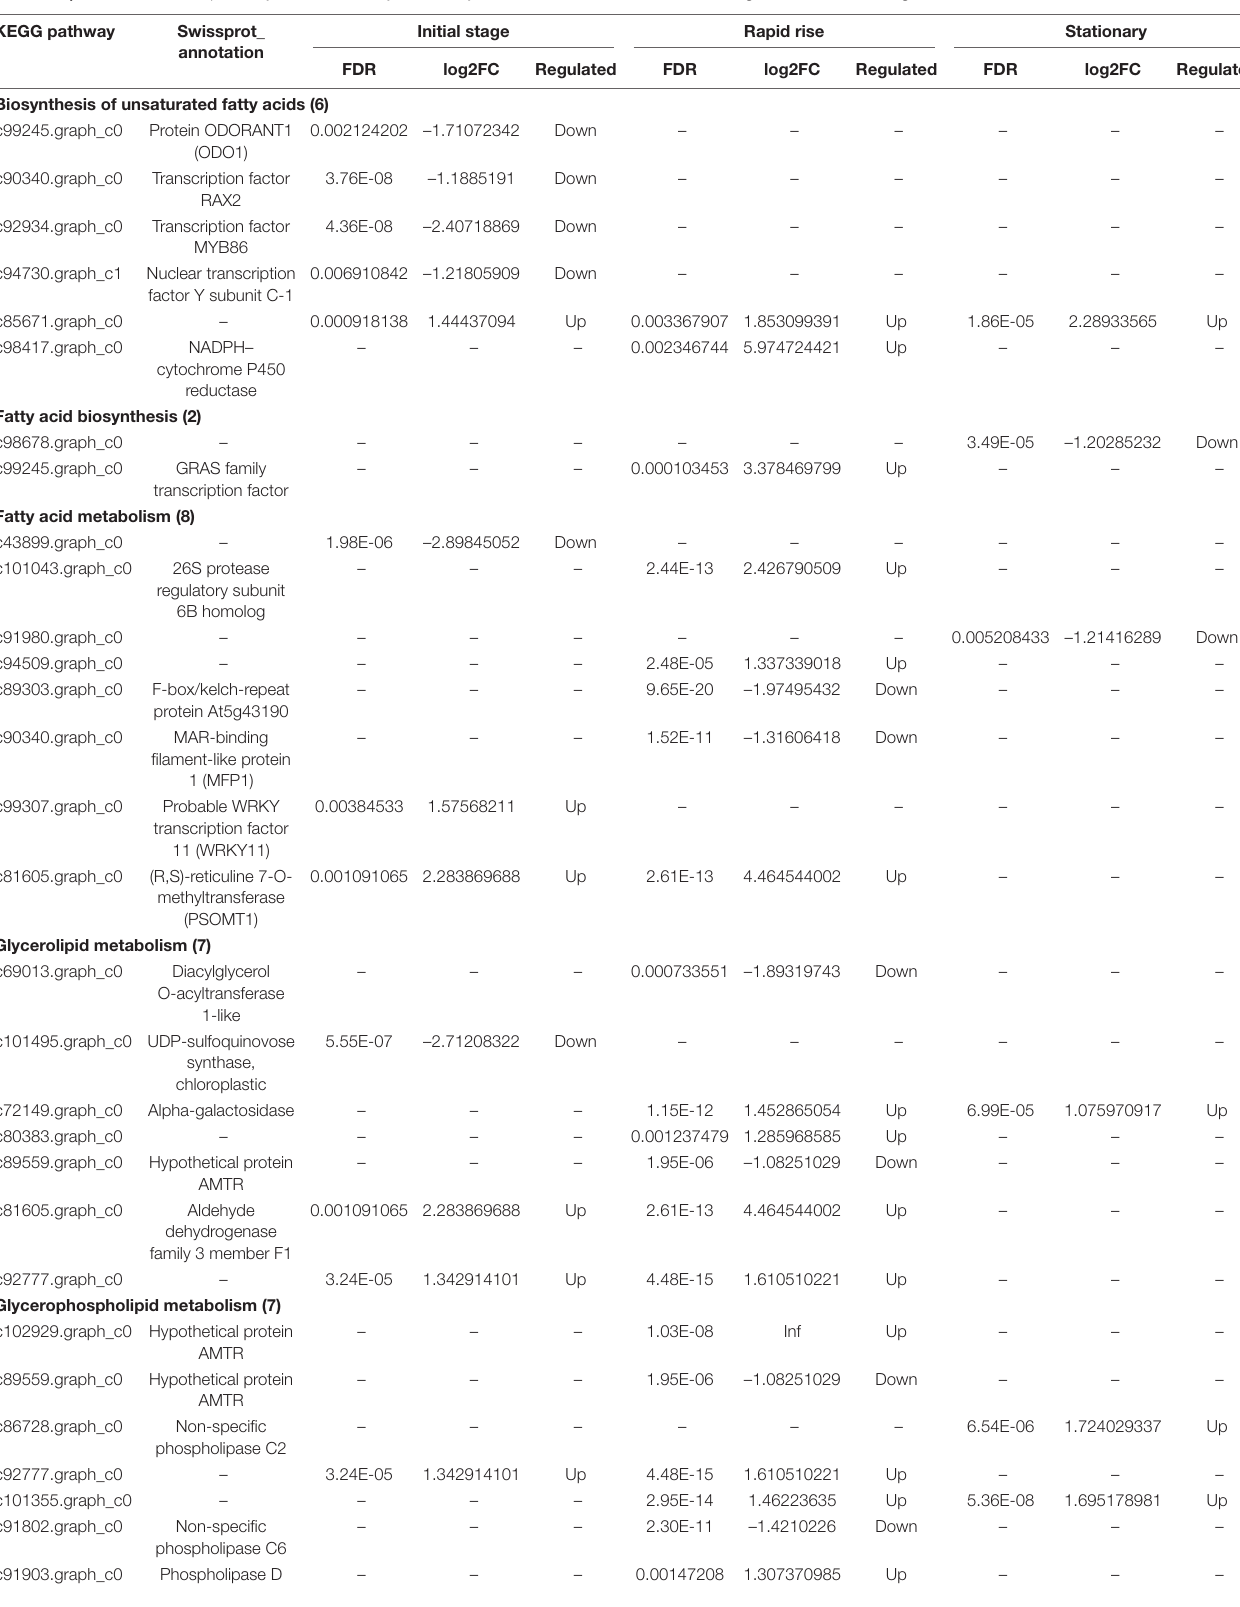
TABLE 1 | DEGs involved in pathways related to fatty acid biosynthesis and metabolism between T. grandis ‘Xifei’ and T. grandis